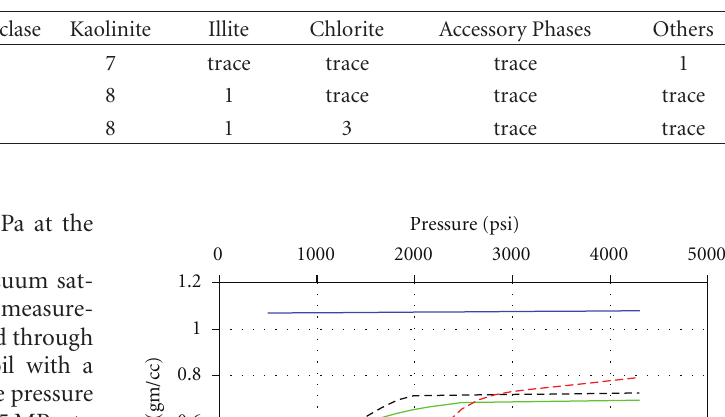
Table 2: QEMSCAN mineral volume (%) of the three zones.